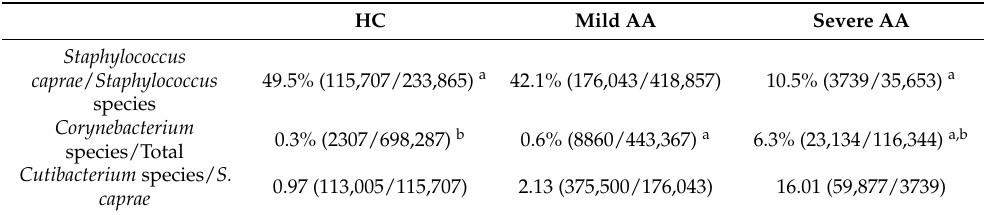
Table 2. Potential prognostic markers associated with the scalp microbiota of alopecia areata (AA)